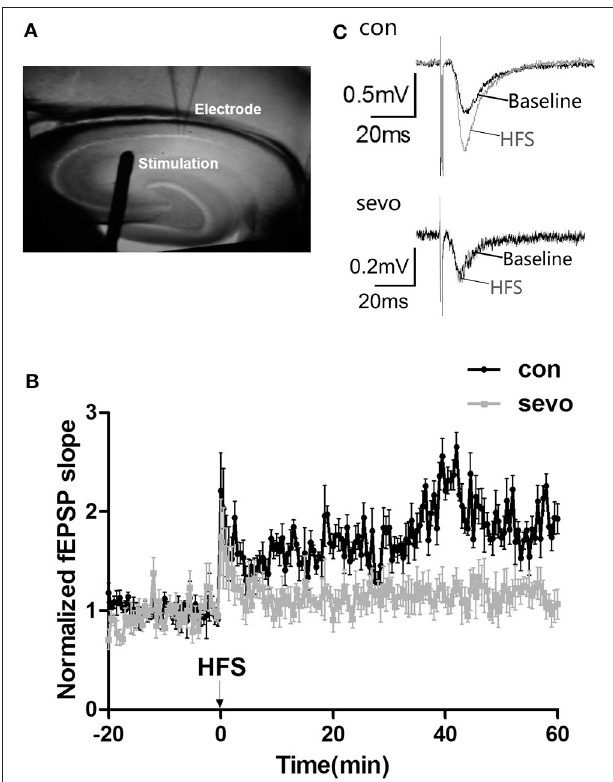
FIGURE 3 | Repeated sevoflurane exposure abolished LTP in the hippocampus. (A) Schematic representation of bipolar stimulating and recording electrode placement. (B) Tetanic stimulation (one bout of stimulation at 100Hz) induced LTP in the Schaffer collateral-CA1 pathway of rat hippocampal slices. (C) Representative traces of the fEPSP waves were recorded at baseline (the black line) and after repeated sevoflurane exposure (the gray line); early-life sevoflurane exposure impaired LTP in the rat hippocampus. N = 9 slices, 4 rats for the control group; n = 8 slices, 4 rats for the sevo